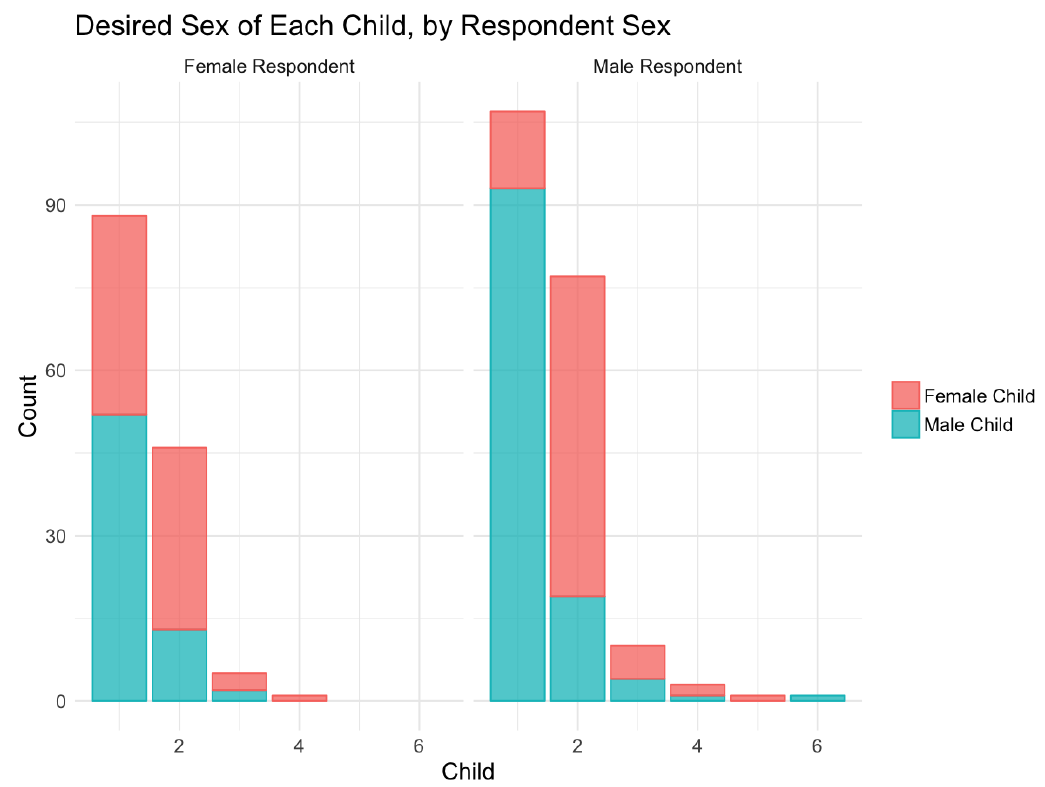
Figure 5. Desired sex of each child, by gender of the